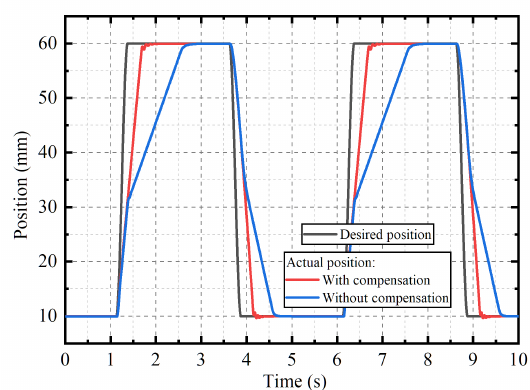
Figure 19. Tracking performance with or without error-related pump pressure compensation.